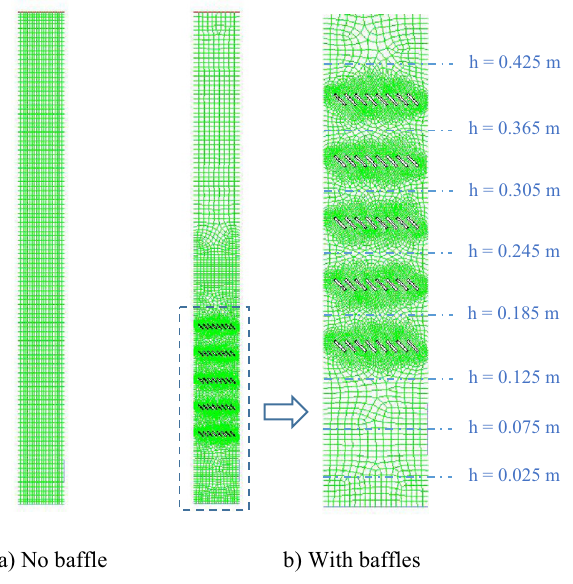
Figure 4. Mesh configurations of the gasifiers with and without the